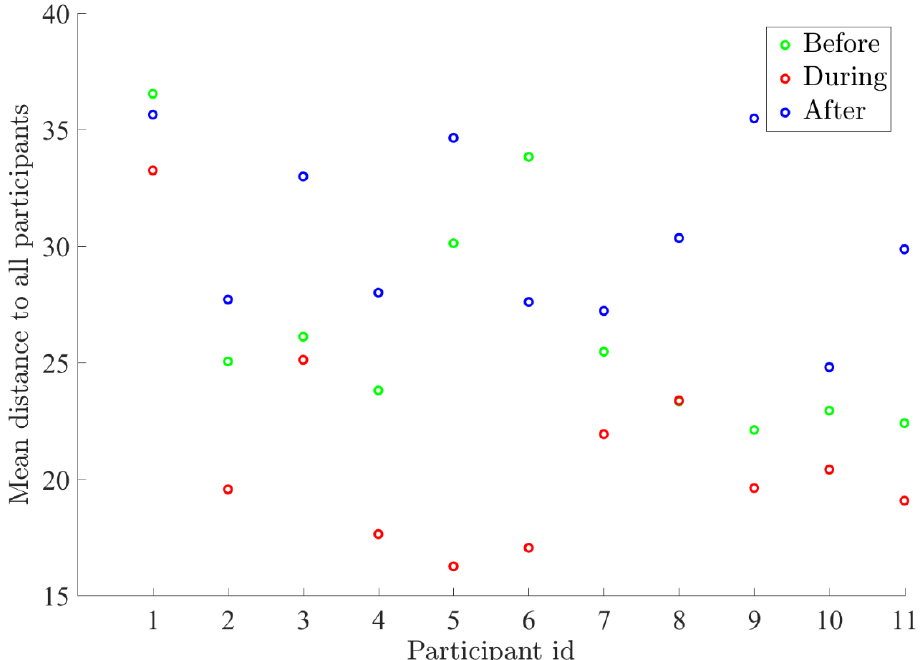
Figure A6. Pairwise synchronization for California’s group. For the majority of participants (10 out of 11) the mean Euclidean distance during the HLI was smaller than before the Heart Lock-In. This means those individuals were more coherent with the group during the Heart Lock-In than they were before. The mean distance after the HLI is bigger (for the majority of participants) than before the application of the technique.